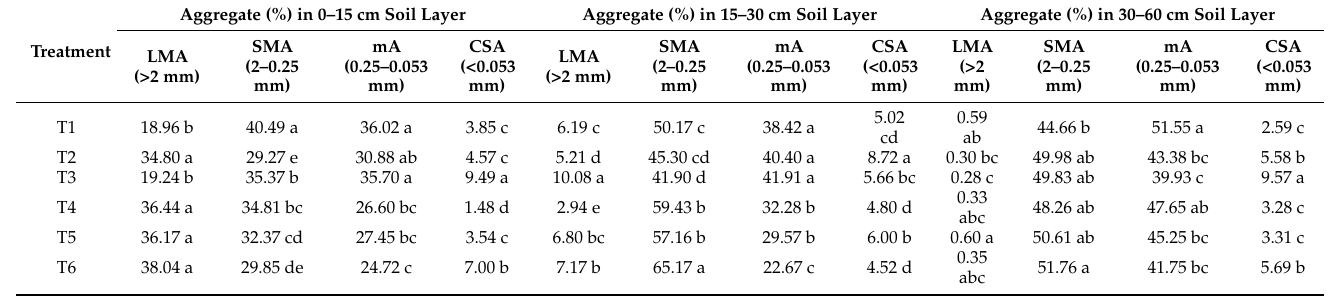
Table 2. Effect of organic amendments on percentage of aggregates at 0–15, 15–30 and 30–60 cm soil depths for different sieve size fractions under rice–wheat cropping system. § Columns with different lower-case letters in each depth are significantly different at p = 0.05 according to Duncan’s multiple-range test.